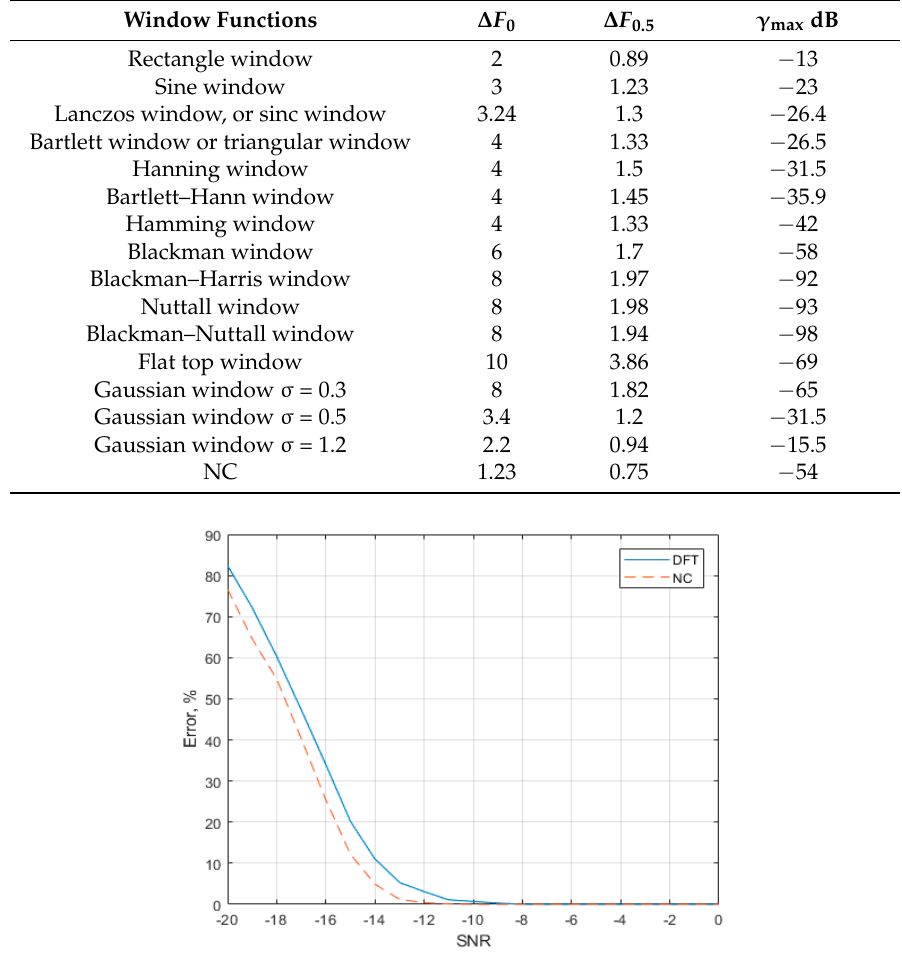
Figure 11. Characteristics of window functions. Table 1. Properties of the main window functions and the proposed method [10].